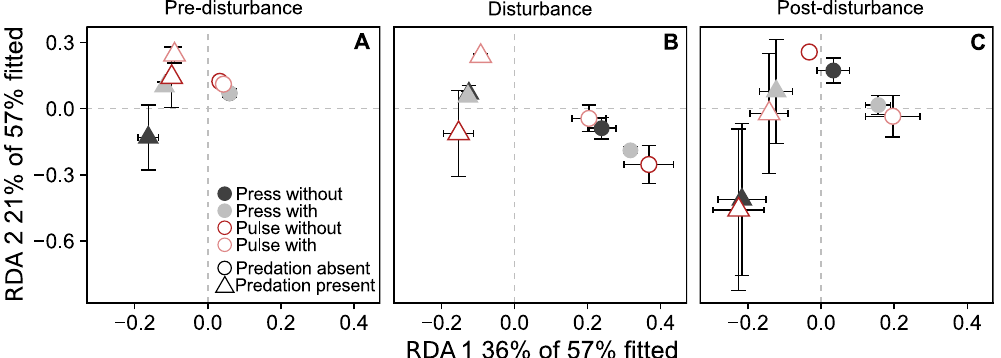
Figure 4. The first two axes of the RDA analysis. Circles represent the treatments without and triangles with predation. “Press” and “Pulse” are the disturbance types, “with” indicates that the disturbance is coupled with a resource deprivation and “without” is without resource deprivation. Error bars for vertical and horizontal axes display the ± standard error. Both axes are significant (RDA1: F 1,72 = 57.415, p = < 0.001; RDA2: F 1,72 = 33.202, p = <